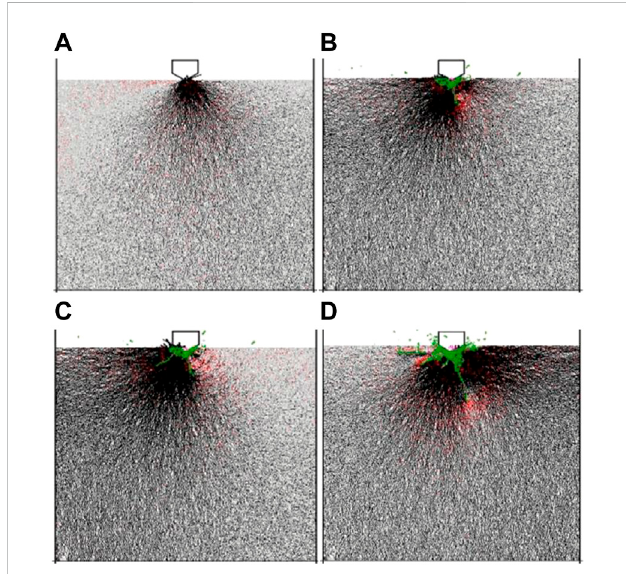
FIGURE 6 Simulation of the failure evolution process of the same